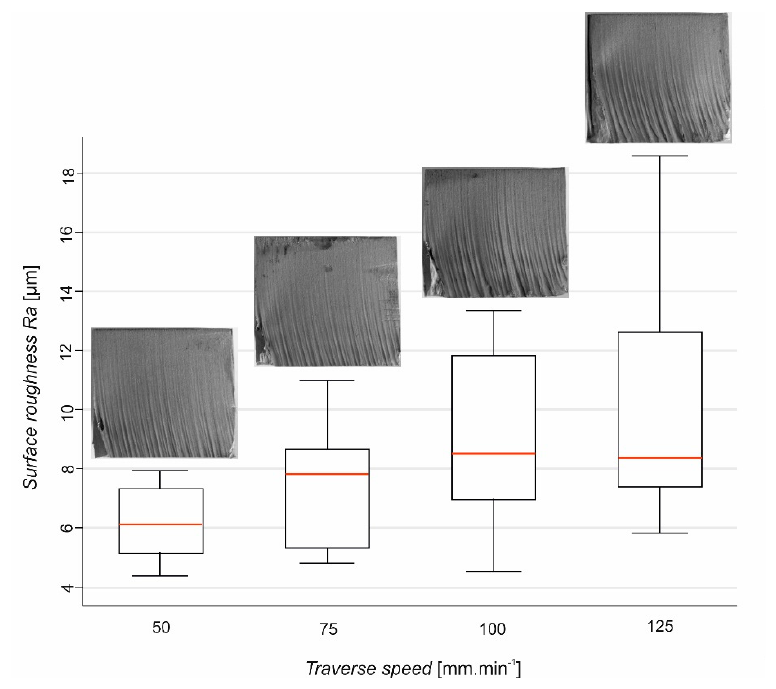
Figure 4. Effect of cutting head feed rate on the surface roughness value Ra. Figure 4. E ff ect of cutting head feed rate on the surface roughness value Ra